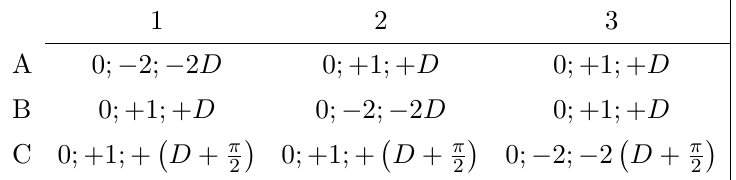
, C3 extracted from table (cid:1) (cid:1) (cid:1)